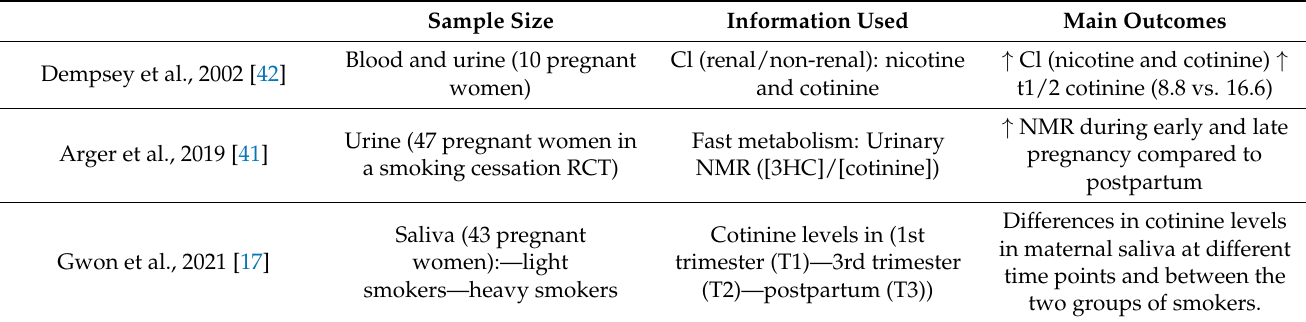
Table 2. Summary of the clinical trials on nicotine metabolism during pregnancy. Sample